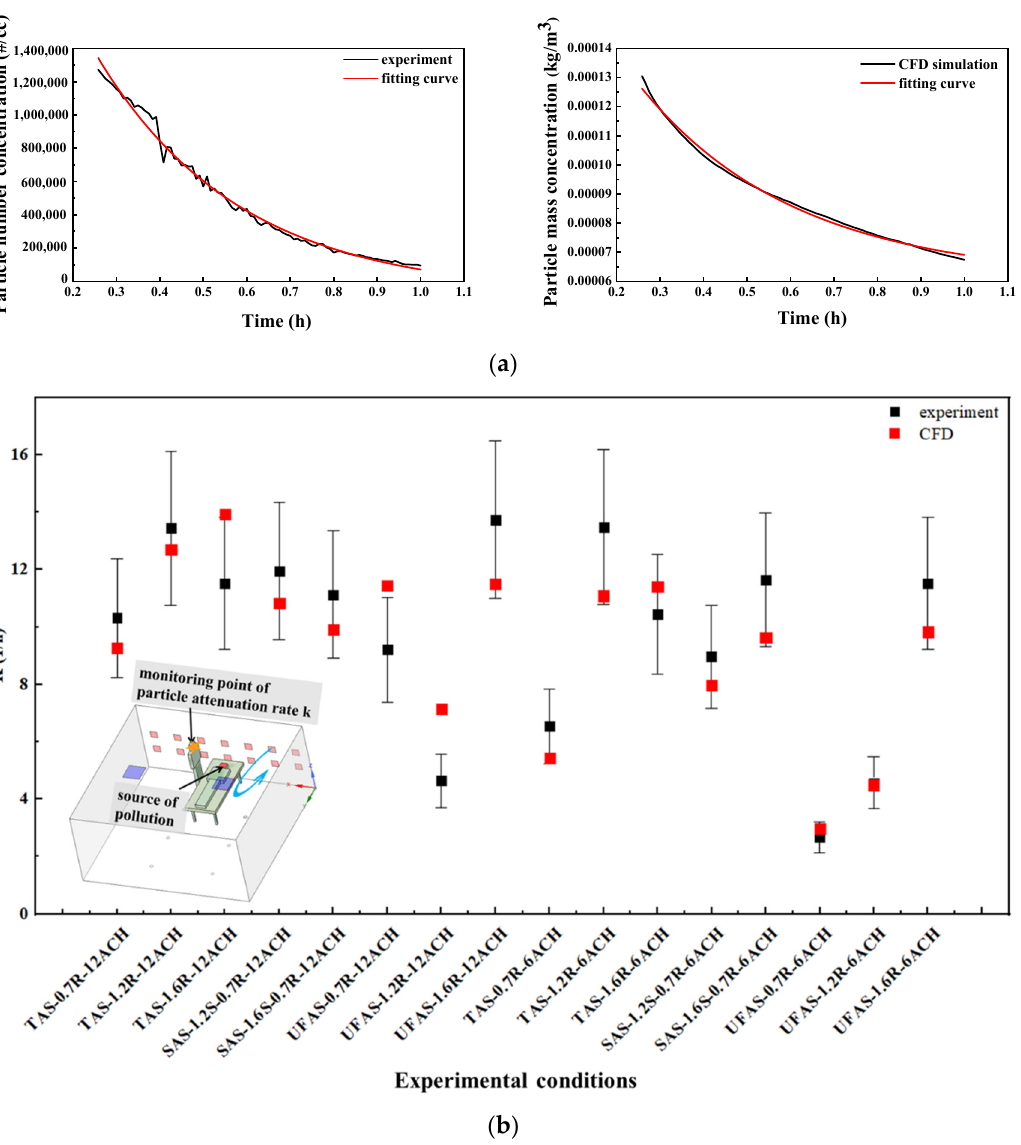
Figure 5. Model verification results. ( a ) Comparison of decay rate between experiment and simulation for one example case (SAS-1.2 m supply-0.7 m return-12 ACH); ( b ) Comparison of experimental and simulation results for 16 conditions.